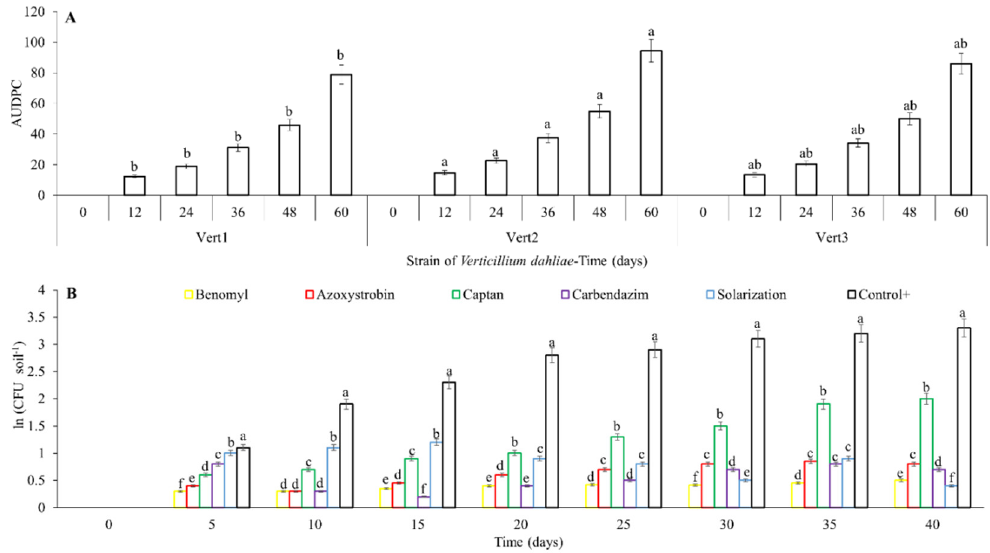
Figure 2. AUDPC and inoculum quantification for management practices of Verticillium dahliae in Hass avocado under net-house conditions. ( A ): evaluation of strain aggressiveness of V . dahliae on Hass avocado. ( B ): effect of chemical fungicide and solarization on soil inoculum of V . dahliae . Error bars represent the confidence interval of the mean, validated by Tukey mean separation test. Equal letters indicate that there are no significant differences ( p > 0.05).